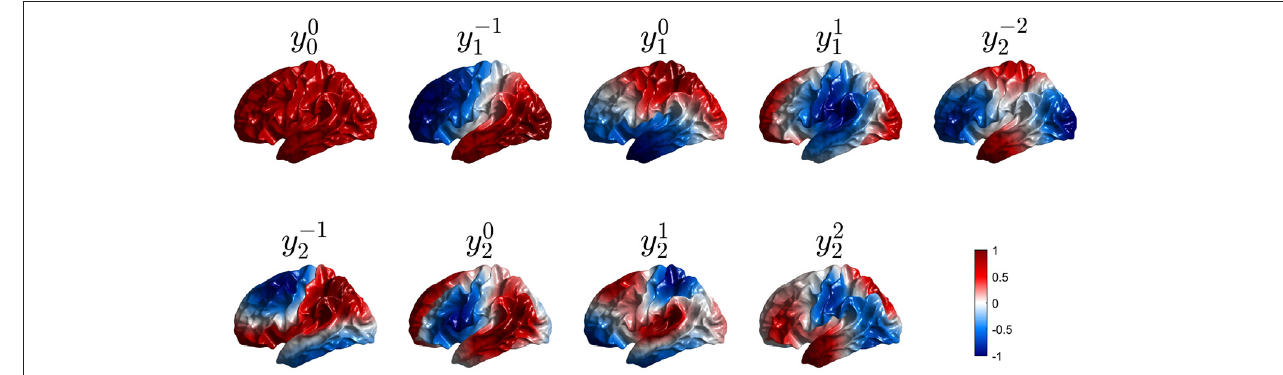
FIGURE 7 | First nine real eigenmodes on a convoluted cortical hemisphere. In each case they are labeled y m l by analogy with the Y m l and normalized to a maximum value of unity; regions of opposite polarity are colored red and blue as shown in the color bar.